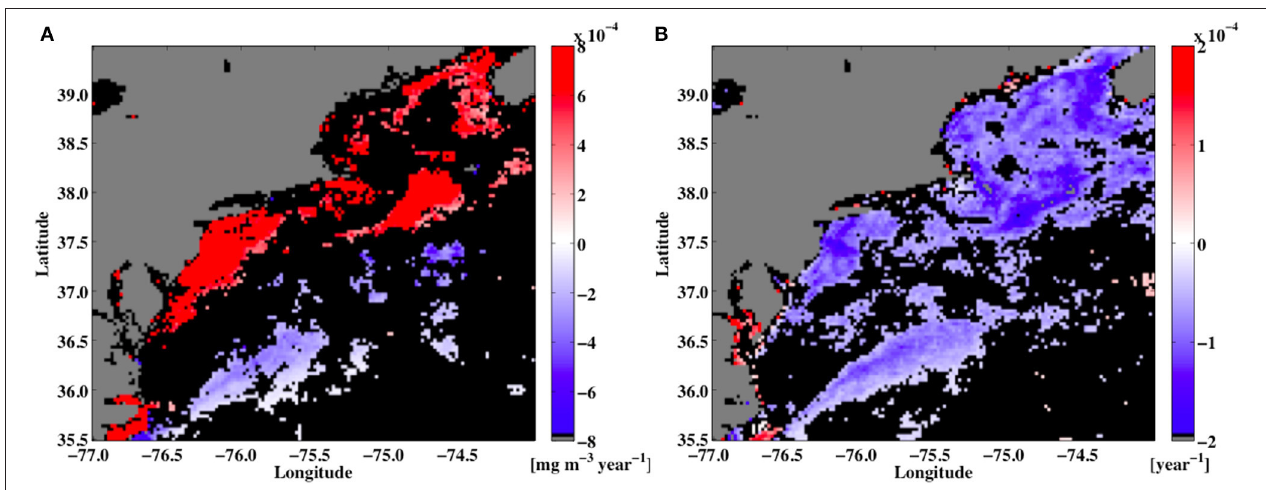
FIGURE 12 | The trend line slopes of (A) seatellite chlorophyll a [mg chla m − 3 year − 1 ] and (B) shannon Diversity Index [H; year − 1 ] at each point over a 15-year period (2002–2016) in the study region. Regions where the slopes were insignificant are shown in